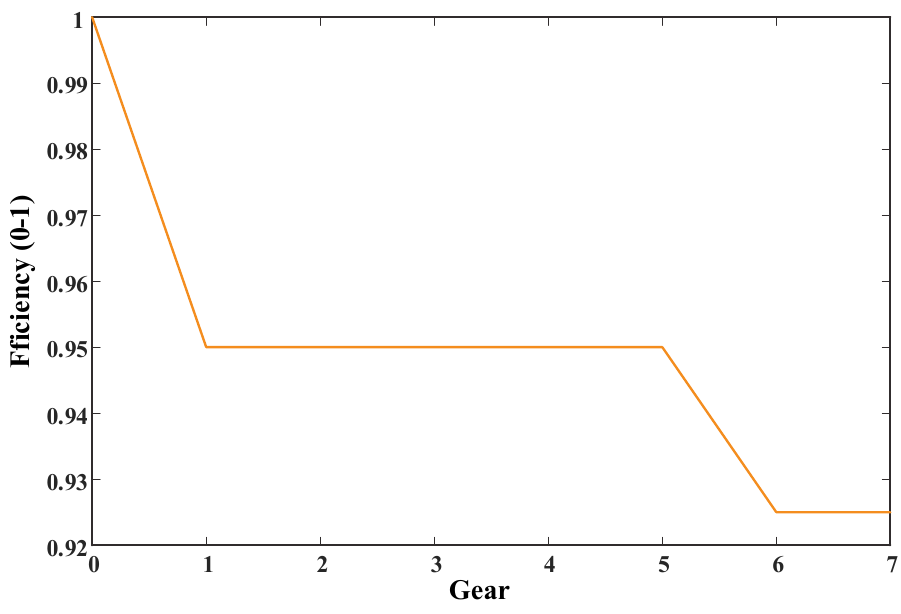
Figure 5. Transmission efficiency in different gears.